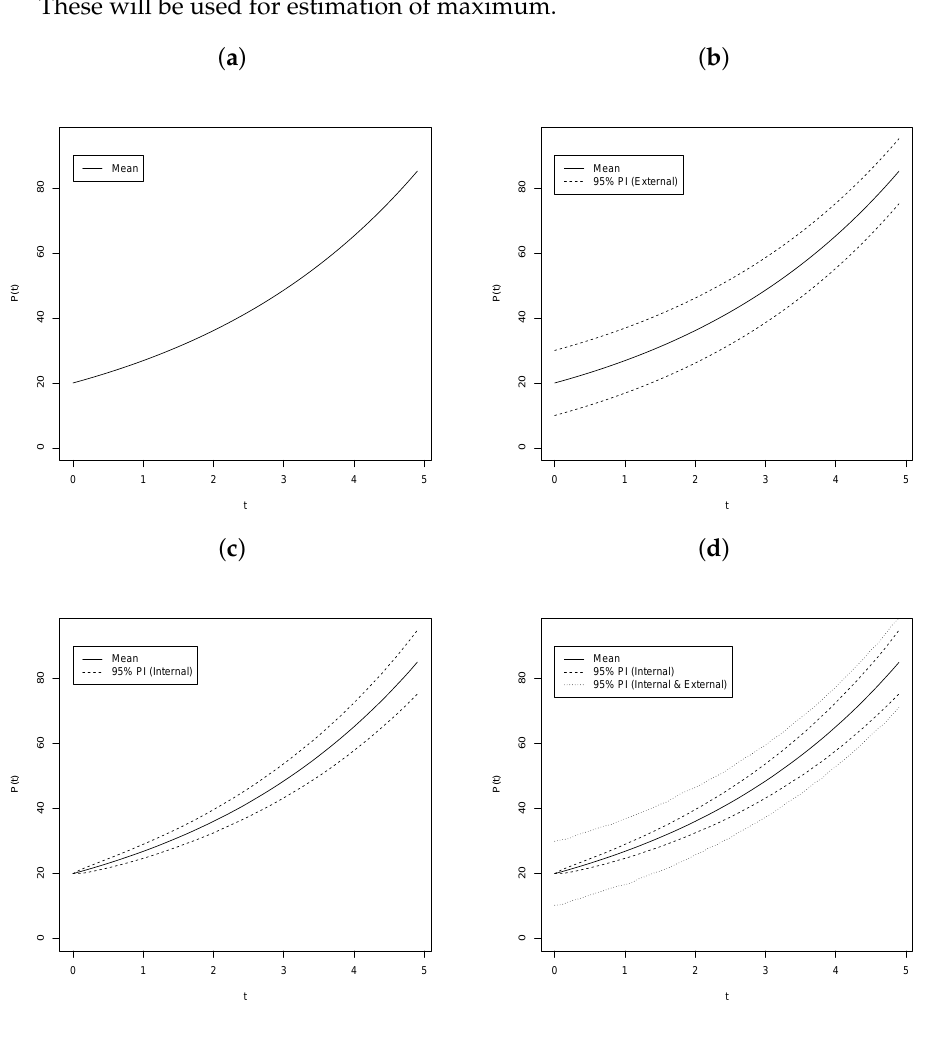
Figure 1. Trajectoriesfor simple population growth equation with: No Error ( a ), External Error ( b ), Internal Error ( c ), and Internal and External Error ( d